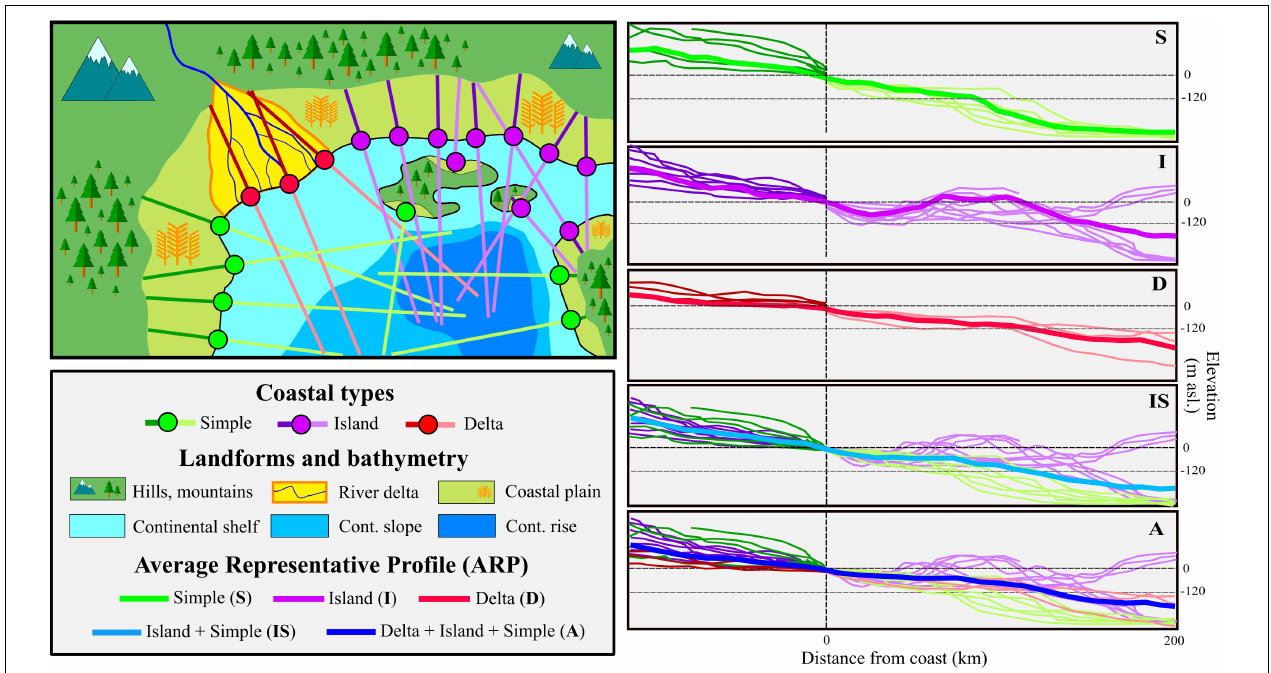
FIGURE 2 | Average representative profile (ARP) and coastal type schematization. The bathymetry classes are based on elevation and slope of the ocean floor. Pinet (2003) defines the three main bathymetry classes based on depth below sea level and topographical slope. Continental shelf is the shallow and relatively flat part of the ocean floor with its depth below sea level not exceeding 120 m below sea level (assumed to be the lowest sea level throughout a glacial cycle, see Figure 6 ). At the edge of the continental shelf, there is an abrupt change in slope which marks the beginning of the continental slope. At the end of continental slope is the continental rise that is defined by lower slope and large depths (generally deeper than 3000 m below sea level).